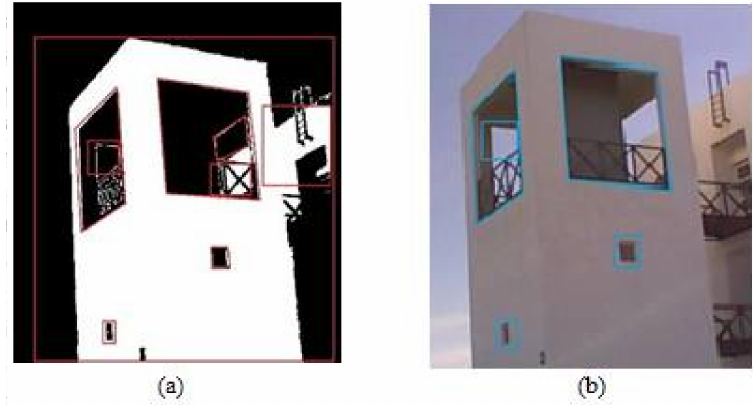
Figure 5. Window identification results, campus building: ( a ) identified rectangular formations in the building through the application of Hough transform; and ( b ) rectangular shapes selected via the rectangular elimination condition as in [31]. All the formations correspond to the building’s